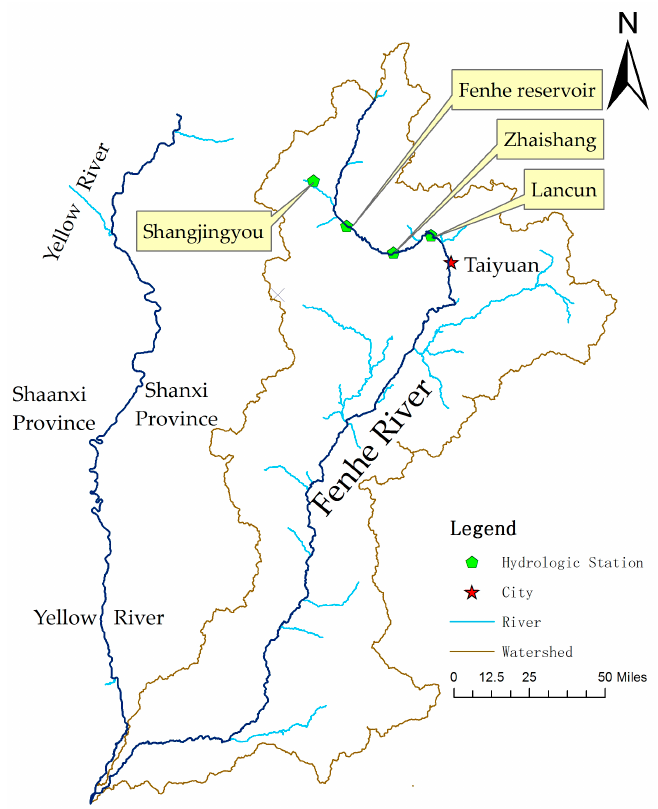
Figure 1. Locations of four hydrologic stations in the Fenhe River basin of China.